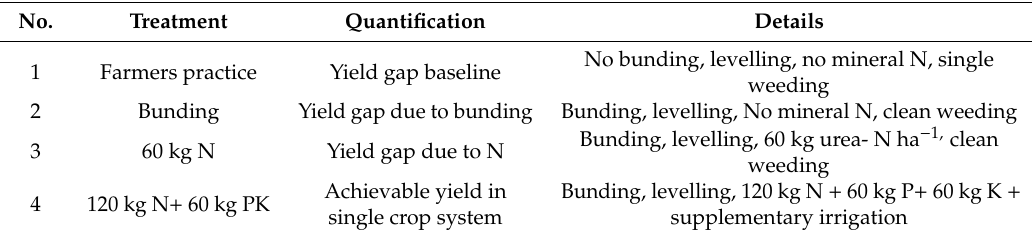
Table 2. Treatment applied in three hydrological positions of Kilombero floodplain in 2015, 2016 and 2017. No. Treatment Quantification